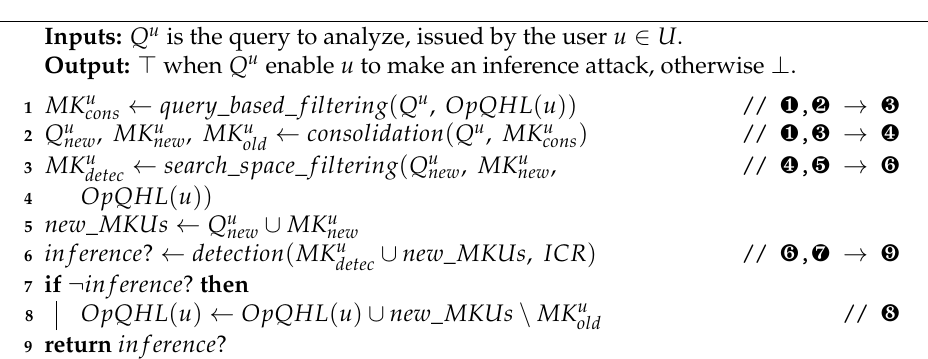
Figure 4. Complete workflow of our RICE-Sy with the main function.